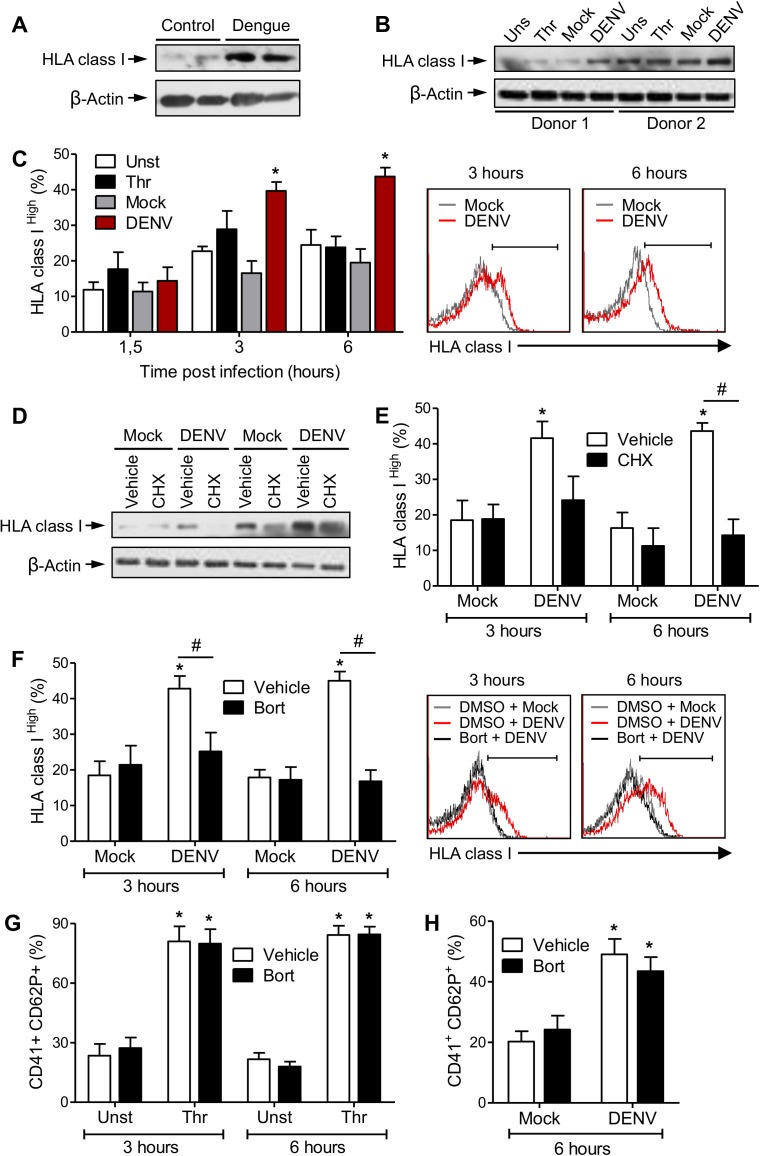
Increased HLA class I on DENV-infected platelets depends on protein translation and proteasome activity.(A) Western blot analysis for HLA class I and β-actin in freshly isolated platelets from two healthy control volunteers and two dengue-infected patients. (B-H) Platelets isolated from healthy volunteers were kept unstimulated (Unst) or stimulated with thrombin (Thr), DENV or Mock for the indicated times. Panel B shows the overall HLA class I expression in platelets from two independent donors at 6 hours post stimulation; and panel C shows the percent of platelets with high surface expression of HLA class I (HLA class IHigh) in each condition. (D-H) Platelets were exposed to DENV or Mock in the presence of DMSO (vehicle), bortezomib (1 μM) or cyclohexamide (10 μM). Panel D show the HLA class I expression at 6 hours post infection, panels E-F show the percent of HLA class I High expression and panels G-H depicts the P-selectin (CD62P) surface expression in platelets incubated in each condition. Bars represent mean ± standard error of the mean of 3 to 7 independent experiments from individual platelet donors. * indicates p<0.05 compared to unstimulated platelets or Mock; # means p<0.05 between platelets treated with Vehicle and Bortezomib or Cyclohexamide. Representative histograms are shown.